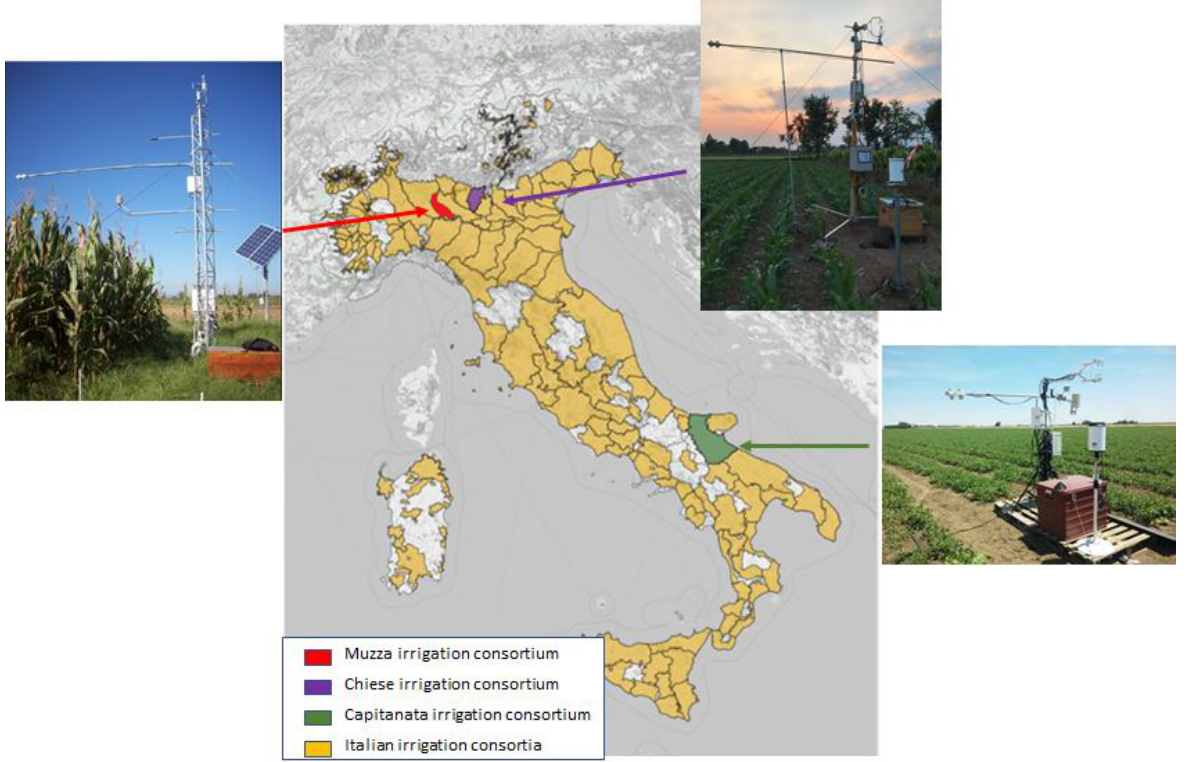
Figure 1. Case studies locations across Italy and the installed eddy covariance stations.